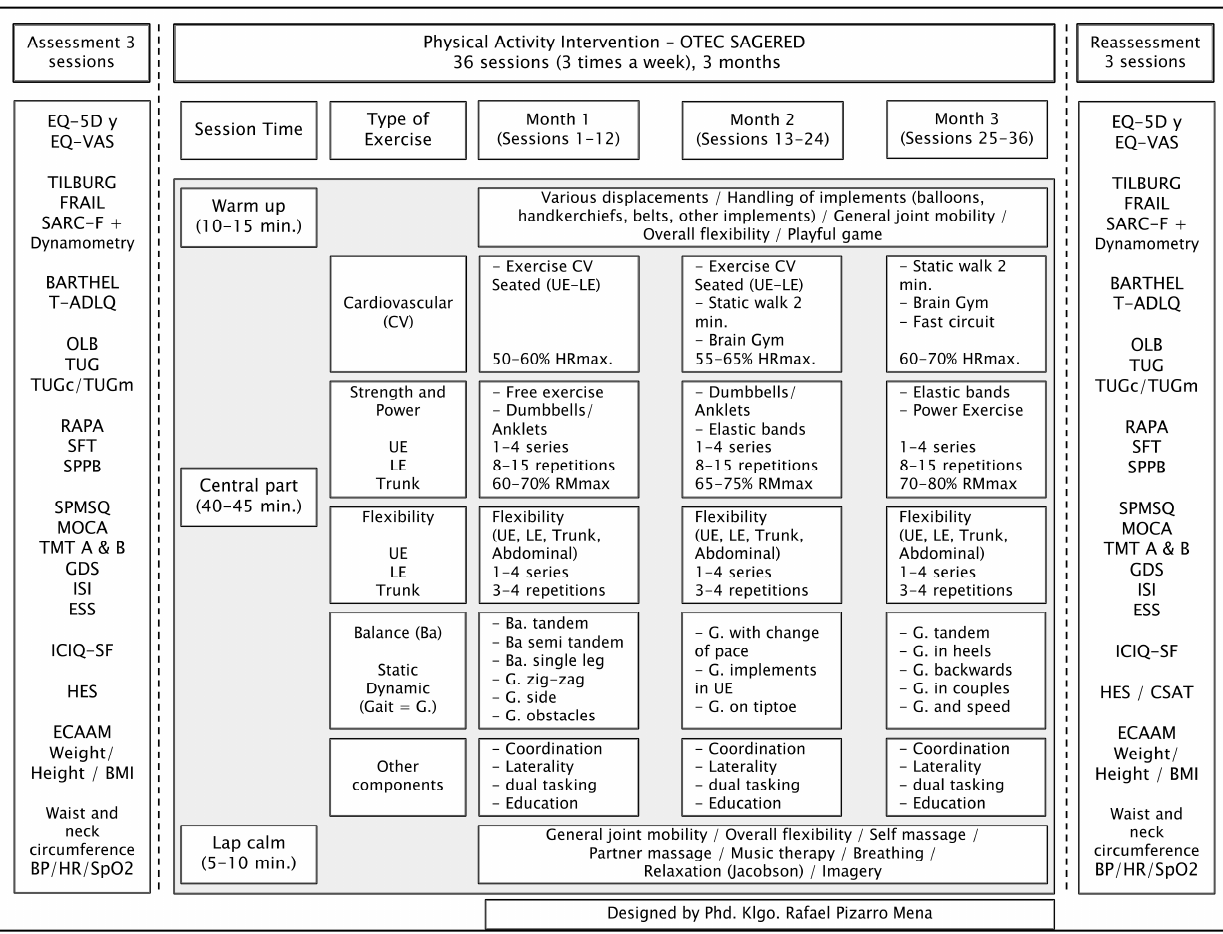
Figure 2. Structured multicomponent physical exercise intervention protocol in community-dwelling older adults. Abbreviations: EQ-5D: EuroQol—five dimensions; EQ-VAS: EuroQol visual ana-